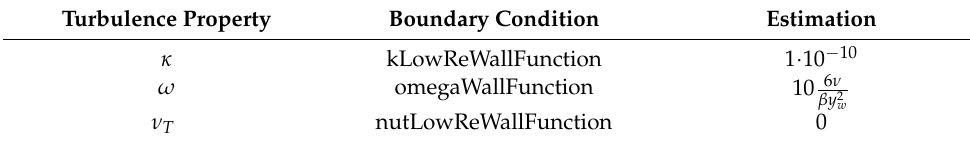
Table 1. Boundary conditions at the wall, expressed in terms of OpenFOAM classes.